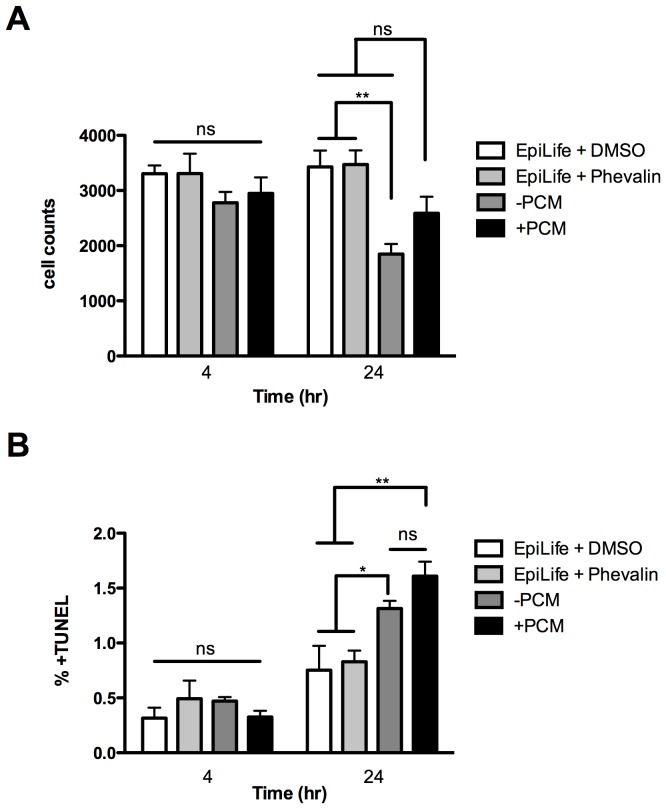
Phevalin does not induce apoptosis in HKs.(A) Cell counts after 4 or 24 hours of exposure to phevalin, -PCM, or +PCM. (B) Percent cells staining positive for TUNEL after 4 or 24 hours of exposure to phevalin, -PCM, or +PCM. Data represent ± SEM, n = 6, *p<0.05, ** p<0.01, ns, not significant, p>0.05.